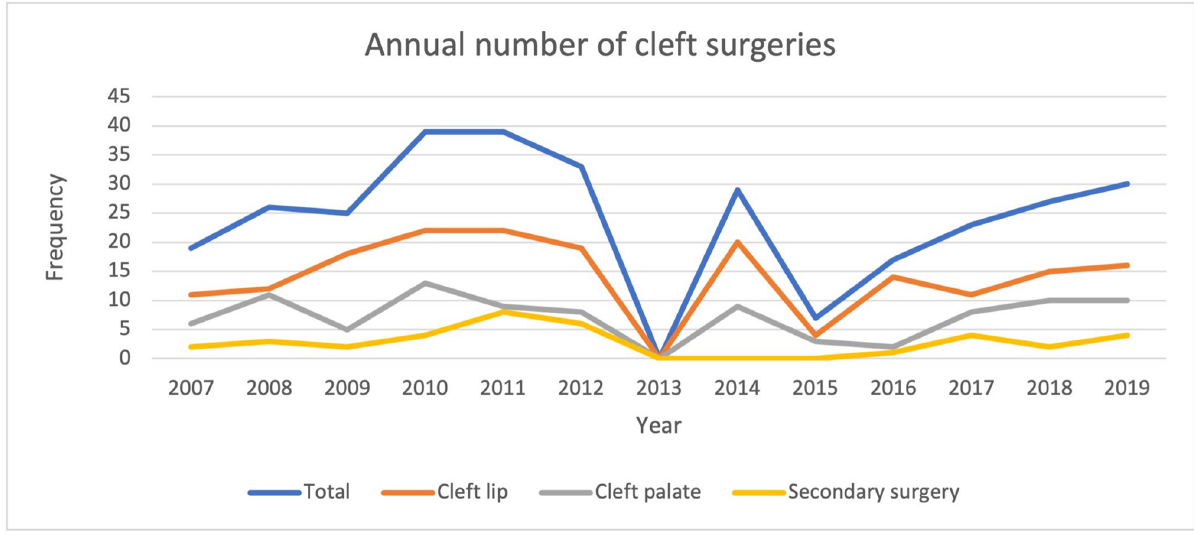
Fig 1. Annual trends in cleft surgeries.